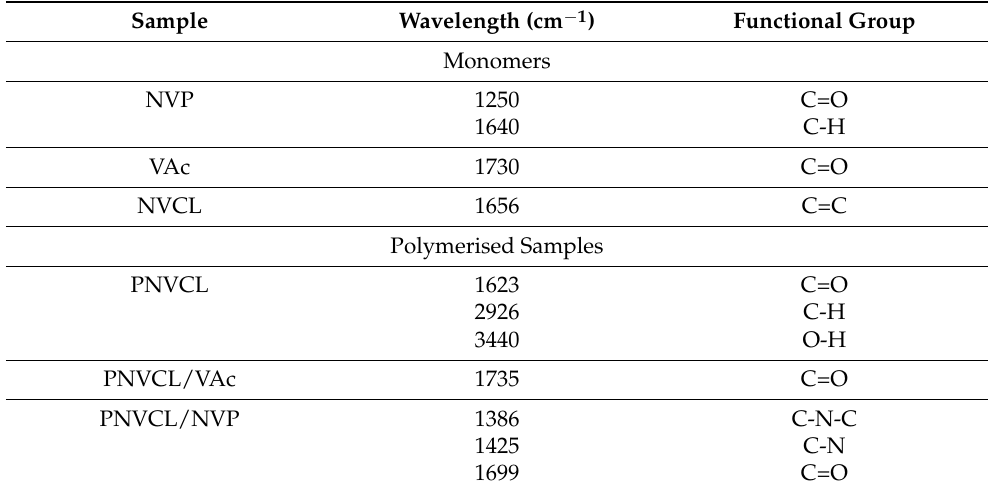
Table 3. Characteristic peaks obtained via ATR-FTIR analysis and the interpretation